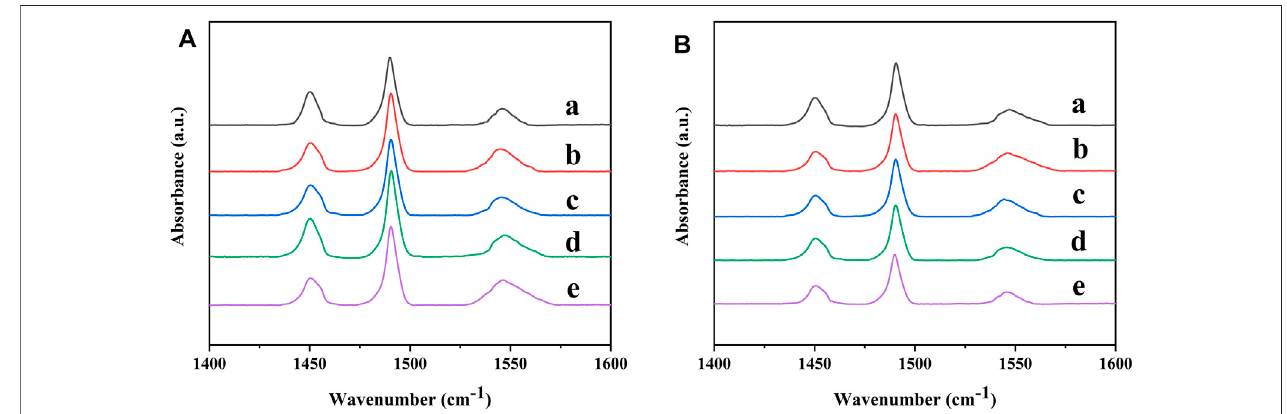
FIGURE6| Py-IR spectra ofNi-modi fi ed SAPO-11 molecular sieves:(a) 4Ni-SAPO-11, (b)3Ni-SAPO-11, (c) 2Ni-SAPO-11, (d) 1Ni-SAPO-11, and (e) SAPO-11 at 200 ° C (A) and 350 ° C (B) .